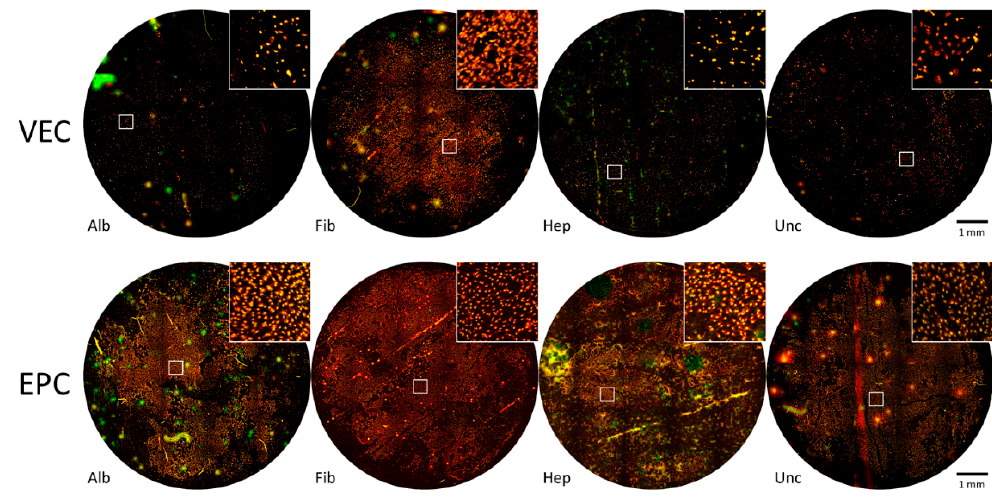
Figure 4. Stitched whole-mount microscopy images of acridine orange staining of BNC grafts seeded with vascular endothelial cells (VECs, upper row) and endothelial progenitor cells (EPCs, bottom row) under static conditions. The region of interest outlined in white is shown in enlarged scale in the upper right image section for each coating. While a rather confluent cell layer of VECs was only found on fibronectin-coated grafts, EPCs showed a rather confluent growth on all coatings and also uncoated grafts. Alb—albumin, Fib—fibronectin, Hep—heparin, Unc—uncoated.